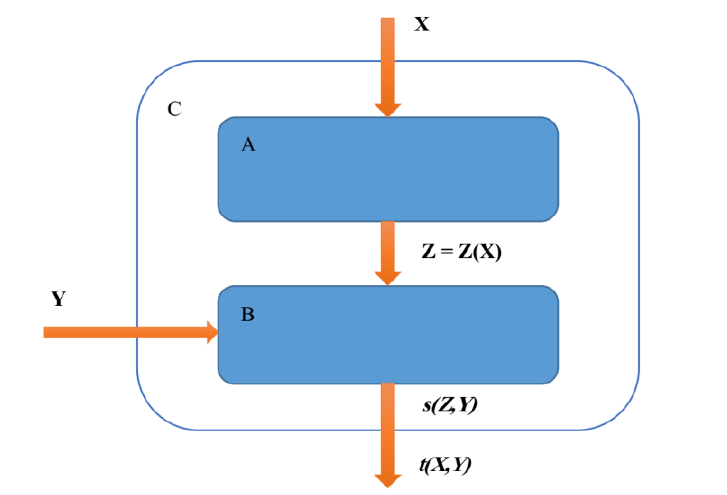
Fig. 1. An outline of digital networks pertaining to the three elementary problems of digital design posed by Ledley (1959, 1960)